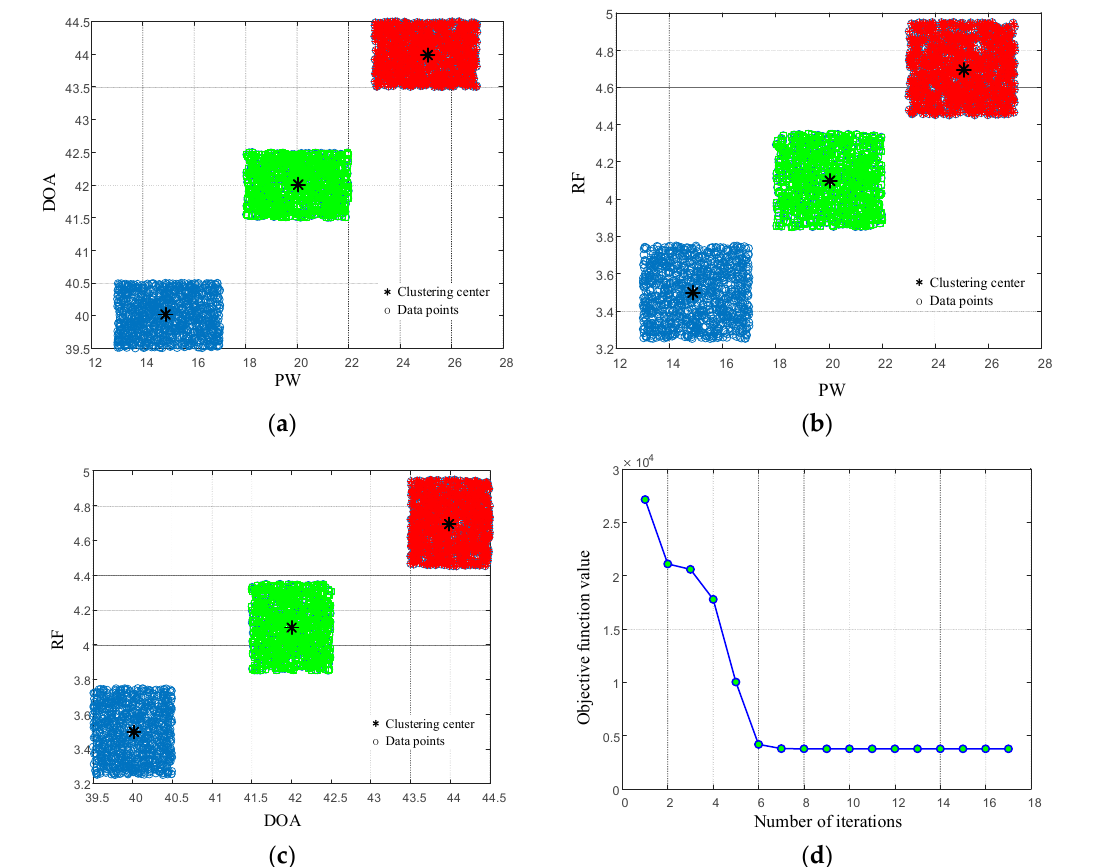
Figure 6. FCM clustering diagrams of the proposed three-dimensional pseudo-center wide-agile joint design parameters. ( a ) PW-DOA two-dimensional cluster diagram. ( b ) PW-RF two-dimensional cluster diagram. ( c ) DOA-RF two-dimensional cluster diagram. ( d ) The change of the objective function.